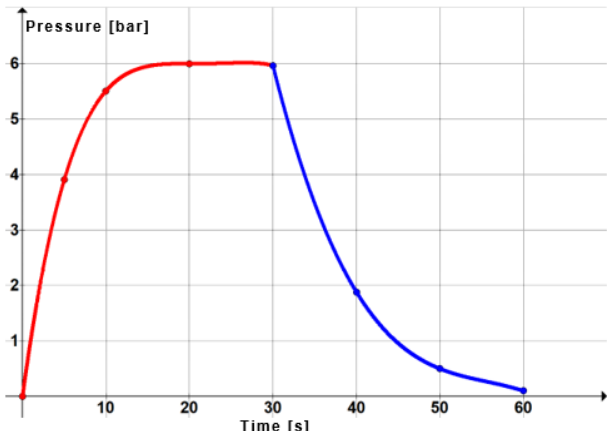
Figure 15. Charging/discharging curves of the pneumatic muscle with air during a rehabilitation exercise cycle.